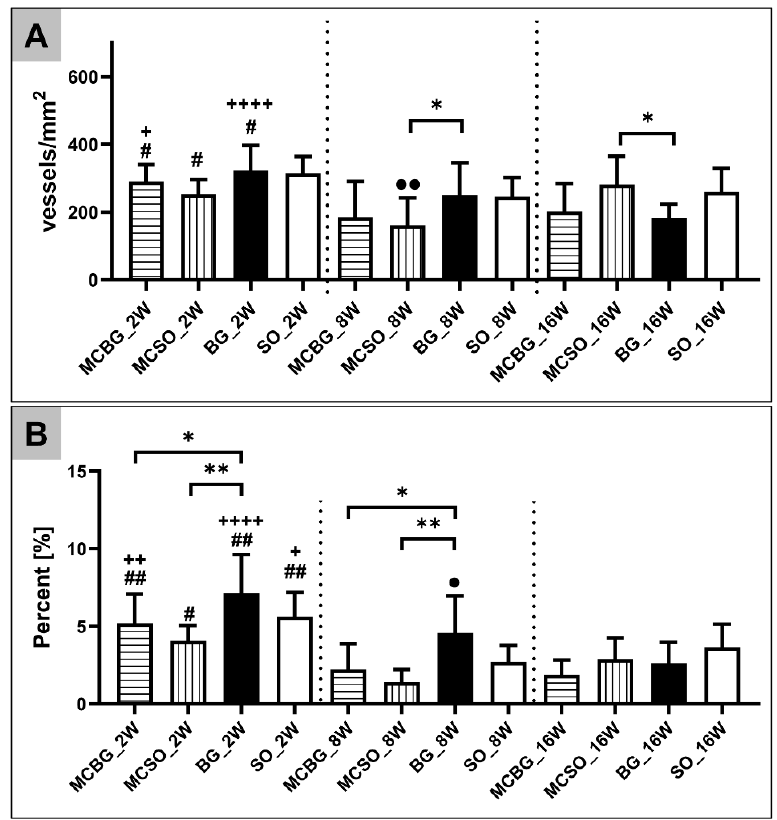
Figure 5. Results of the measurements of ( A ) the vessel density and ( B ) the vascularization percentage at 2, 8, and 16 weeks post implantationem. Intraindividual significant differences are indicated as * p < 0.05 and ** p < 0.01. Interindividual significant differences are indicated as #/+/ • p < 0.05, ##/++/•• p < 0.01, and ++++ p < 0.0001. # = signi fi cant di ff erences between 2- and 8-week datasets; + =